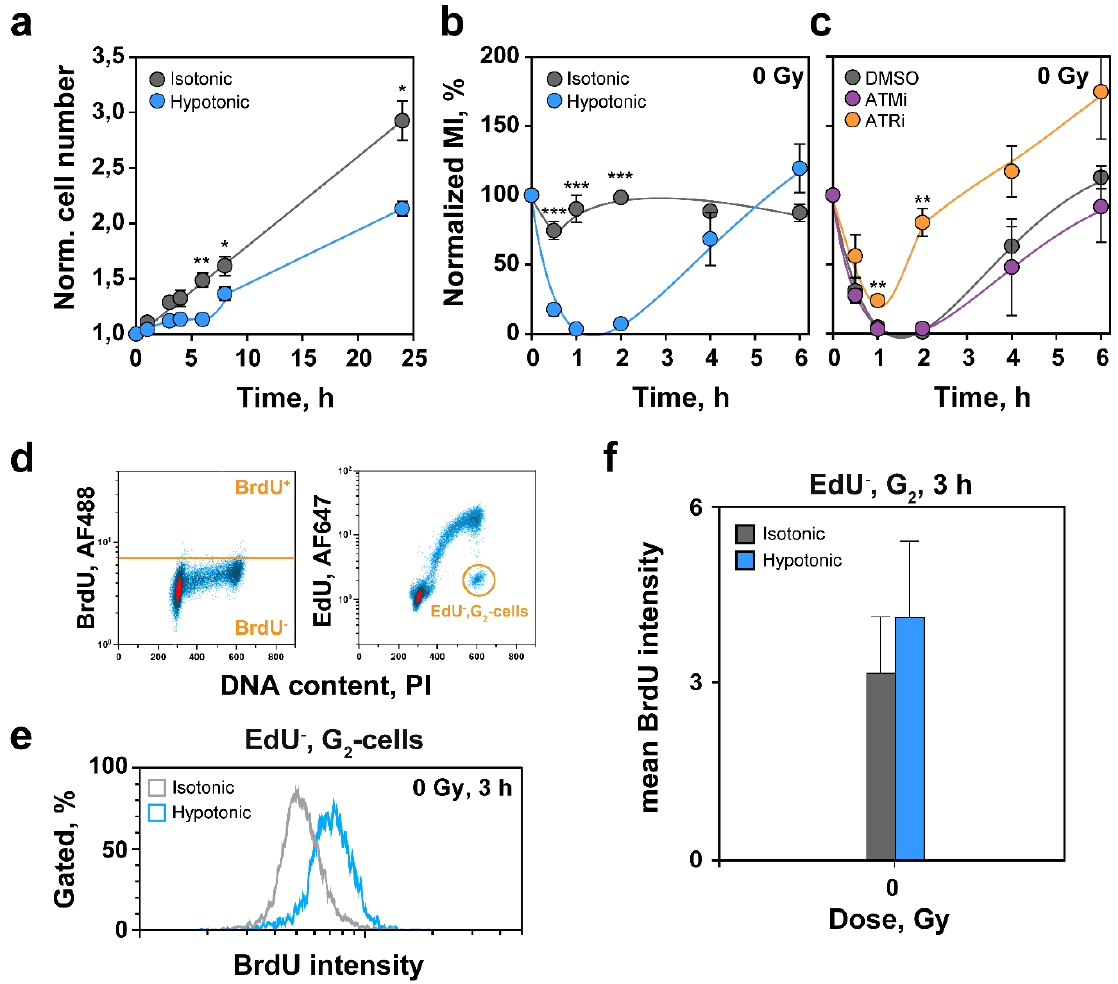
Figure 2. HypoS transiently inhibits cell proliferation. ( a ) Cell proliferation of RPE cells transferred to isotonic (grey symbols) or hypotonic medium (blue symbols). Values are normalized to those measured at 0 h. ( b ) Normalized percent-MI as a function of time for RPE cells exposed to HypoS or maintained in isotonic medium. ( c ) As in b, for cells exposed to HypoS, pretreated for 1 h and then maintained for the duration of experiment with specific inhibitors of ATM (ATMi: KU-55933), ATR (ATRi: VE-821) or solvent (DMSO). Plotted is the mean ± SE from three to five independent experiments. Error bars are visible when larger than the symbols used. ( d ) Outline of the three-parametric FC analysis used to determine ssDNA in G 2 -phase cells. In the left panel, BrdU signal is plotted against the PI signal, and in the right panel EdU against the PI signal. Gates define the populations selected for ssDNA analysis (EdU negative (EdU − ), G 2 -phase). ( e ) BrdU intensity plots measured by FC in RPE cells exposed to HypoS or maintained in isotonic medium for 3 h. Plots represent EdU − , G 2 -phase cells selected using the gating shown in d. ( f ) Arithmetic means of AF488 signal intensity for BrdU measured by FC and gated as in d of RPE cells maintained in isotonic (grey bar) and hypotonic medium (blue bar) for 3 h. Means and errors are calculated from three independent experiments. Differences reaching statistical significance between isotonic and hypotonic treated cells are marked with * p < 0.05, ** p < 0.01 and *** p < 0.001.